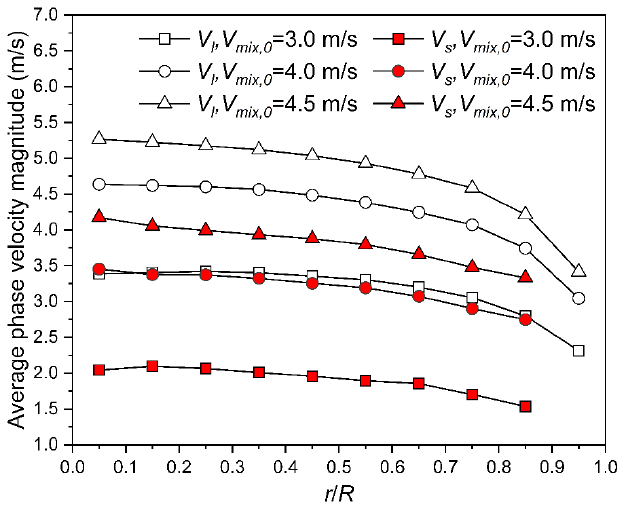
Figure 14. Effects of initial mixture velocity on average phase velocities ( C v ,0 = 5%, d s = 15.0 mm).